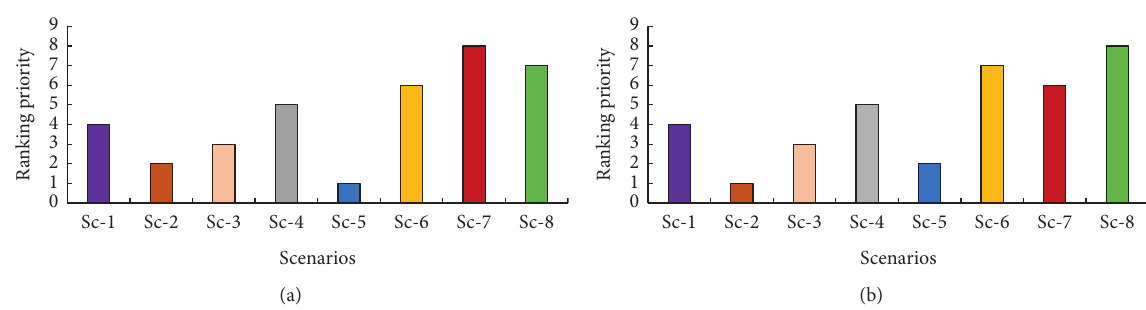
Figure 21: Ranking priority for eight main scenarios with different variable investment costs.